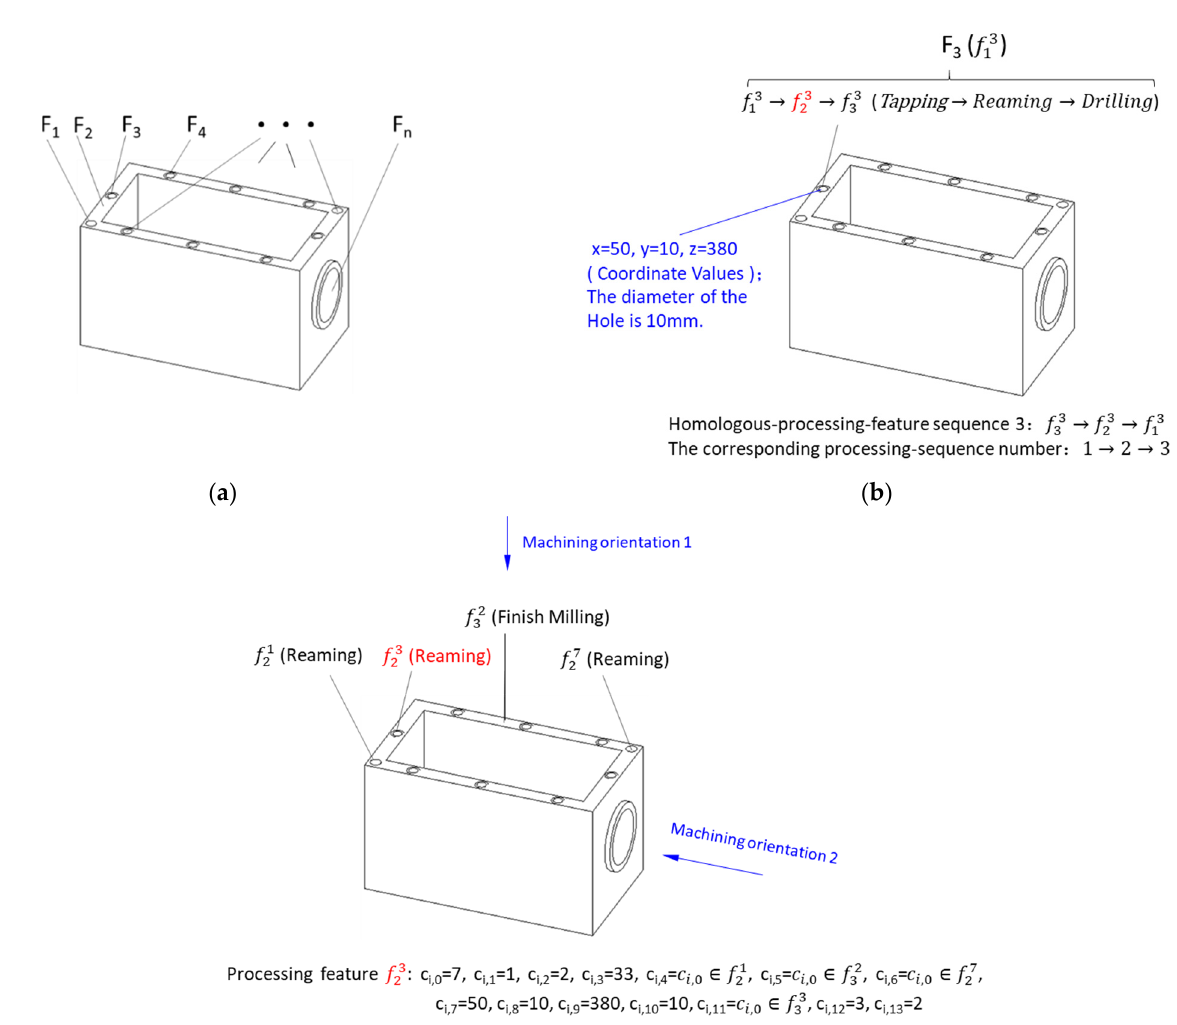
Figure 5. An example of extracting the processing information of a part: ( a ) Obtain all of the final processing features of the part; ( b ) obtain a homologous processing feature sequence by tracing back from a final processing feature; ( c ) extract the processing information of processing feature f 3 2